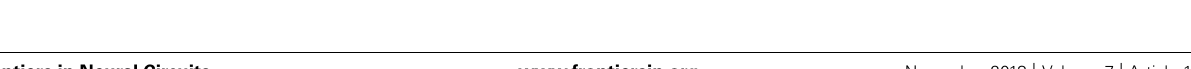
Frontiers in Neural